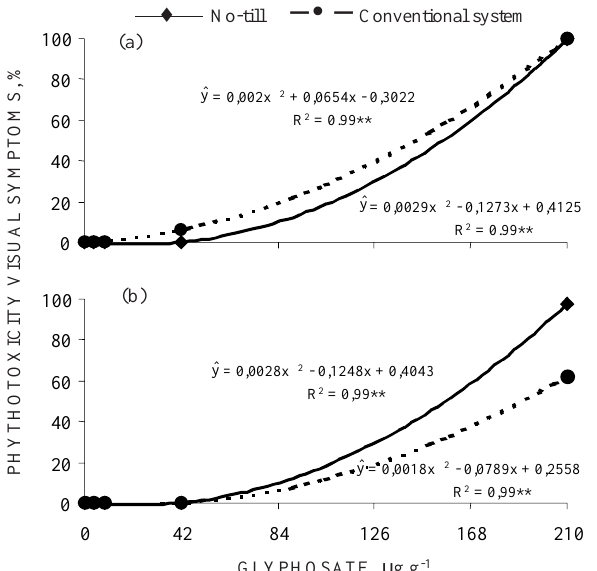
Figure 4. Phytotoxicity symptoms of glyphosate in Panicum maximum at 20 days after germination. (a and b: 24 or 84 days after glyphosate soil application,